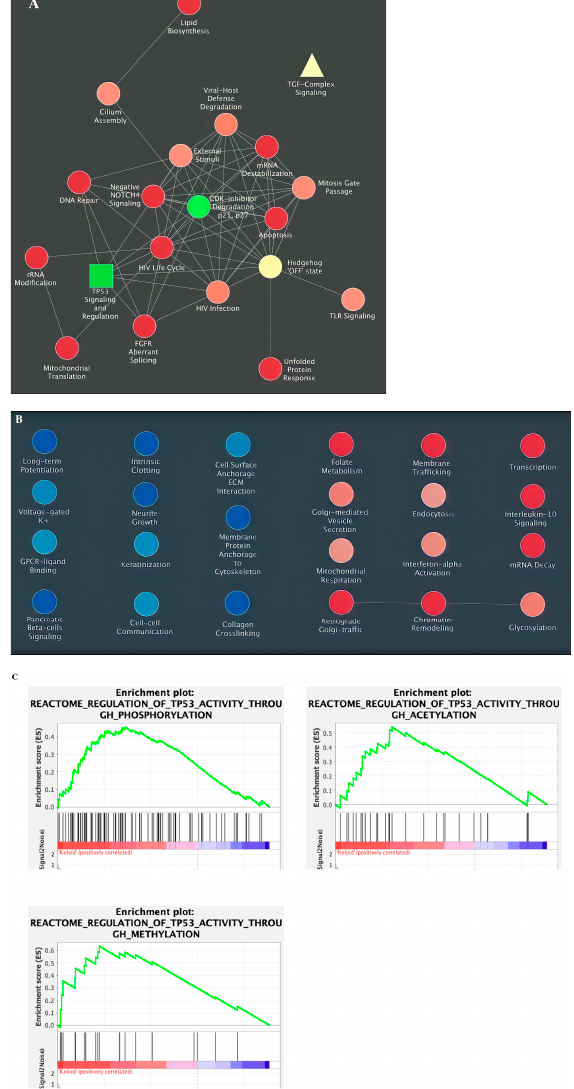
Figure 4. Collapsed clustering of GO-hallmark landscape. ( A , B ) Enriched interactions with TGF- β - signaling (yellow) and TP53, senescence (green); ( C ) GSEA enrichment of TP53 epigenetic modula- tions.